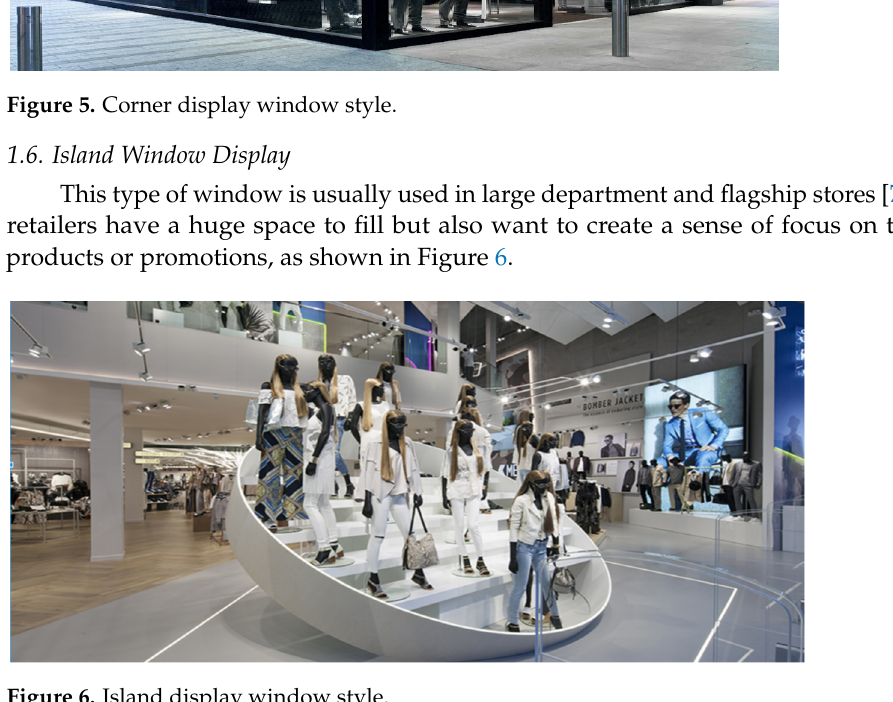
Figure 6. Island display window